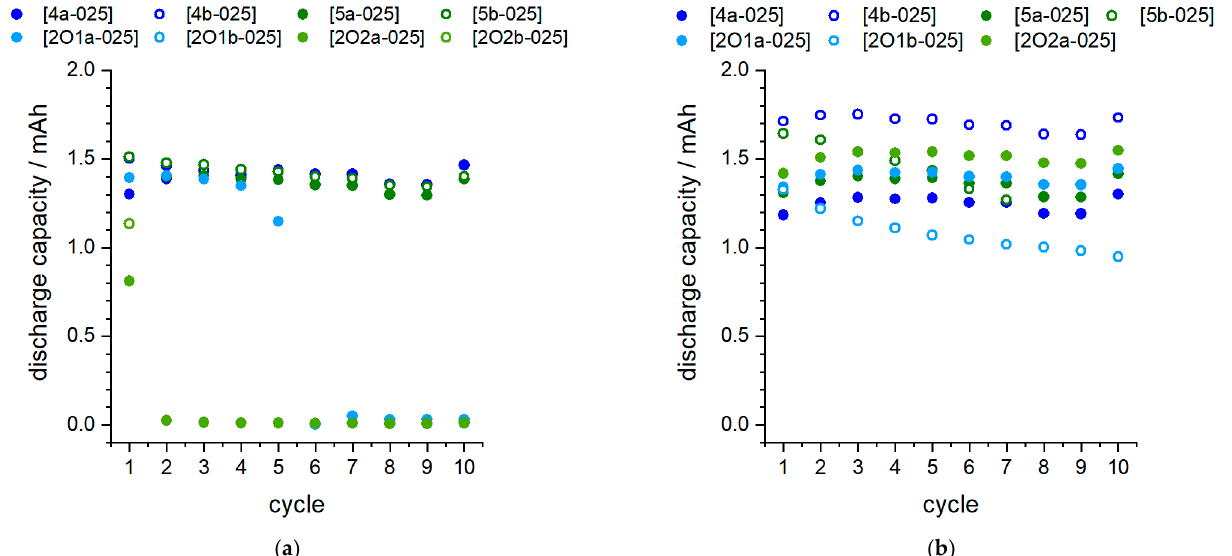
Figure 10. Cycle test in battery cells. ( a ): half ‐ cell, Li vs. LFP; ( b ): full cell, LTO vs. LFP; current rates between 0.02–0.05 C.